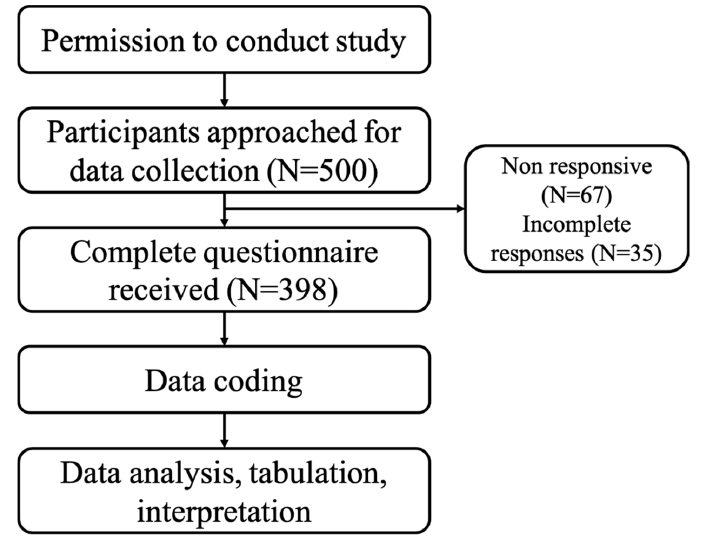
Figure 1. Study Flow